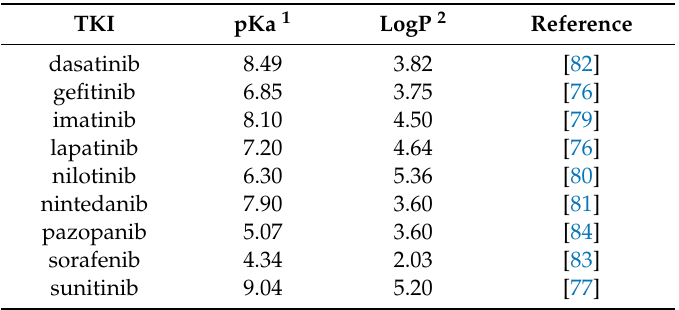
Table 3. List of TKIs known to be sequestered into